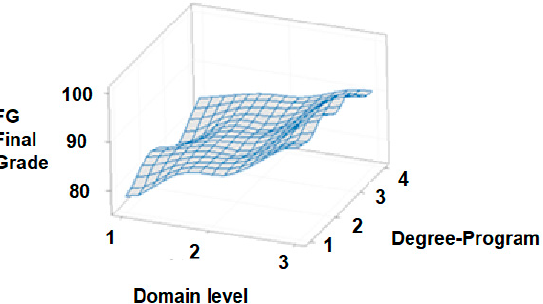
Figure 11. 3D Surface graph of final grade vs. degree program group (with the domain level as the x axis variable) for the EFR competency. The degree program group is described as follow: (1 = Science/Engineering, 2 = Medical Sciences, 3 = Administration/Management and 4 = Law).